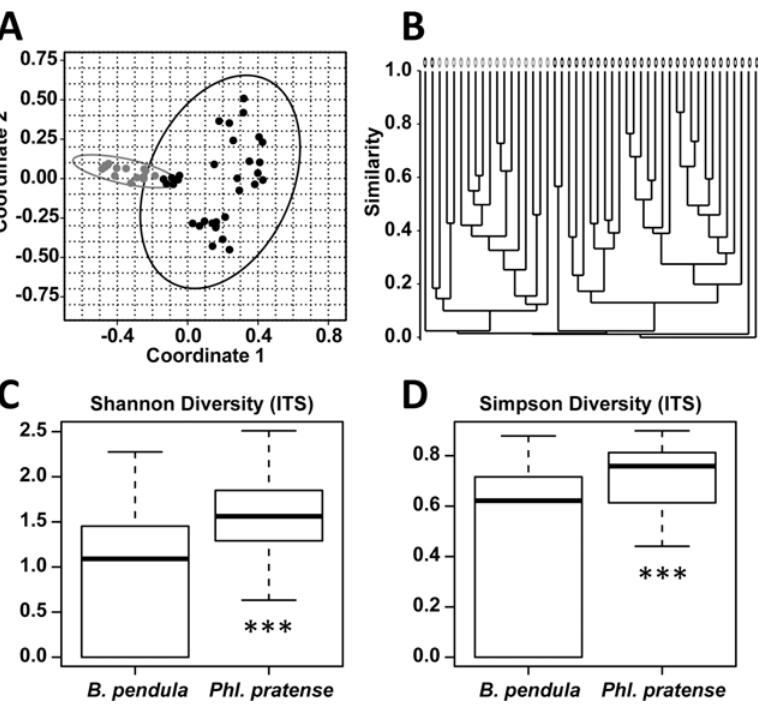
Fig 2. Comparison of fungal pattern on pollen from birch and timothy grass. A) PCoA (Bray-Curtis- Index) of fungal pattern on birch pollen ( Betula pendula ; n = 31; black) and timothy grass pollen ( Phleum pratense ; n = 16; grey) show hardly overlapping 95%-confidence. The significant differences were confirmed by ANOSIM (R = 0.51, p = 0.0001). B) The cluster dendrogramm (Bray-Curtis-Index) demonstrates the separation of the two pollen species due to fungal pattern. C,D) Boxplots of indices weighing species due to their extent of abundance in fungal community on birch- and timothy grass-pollen. In comparison the two groups differed significantly due to low abundant species (Shannon-index, p = 0.006), and also due to high abundant species of fungal composition (Simpson-index, p =